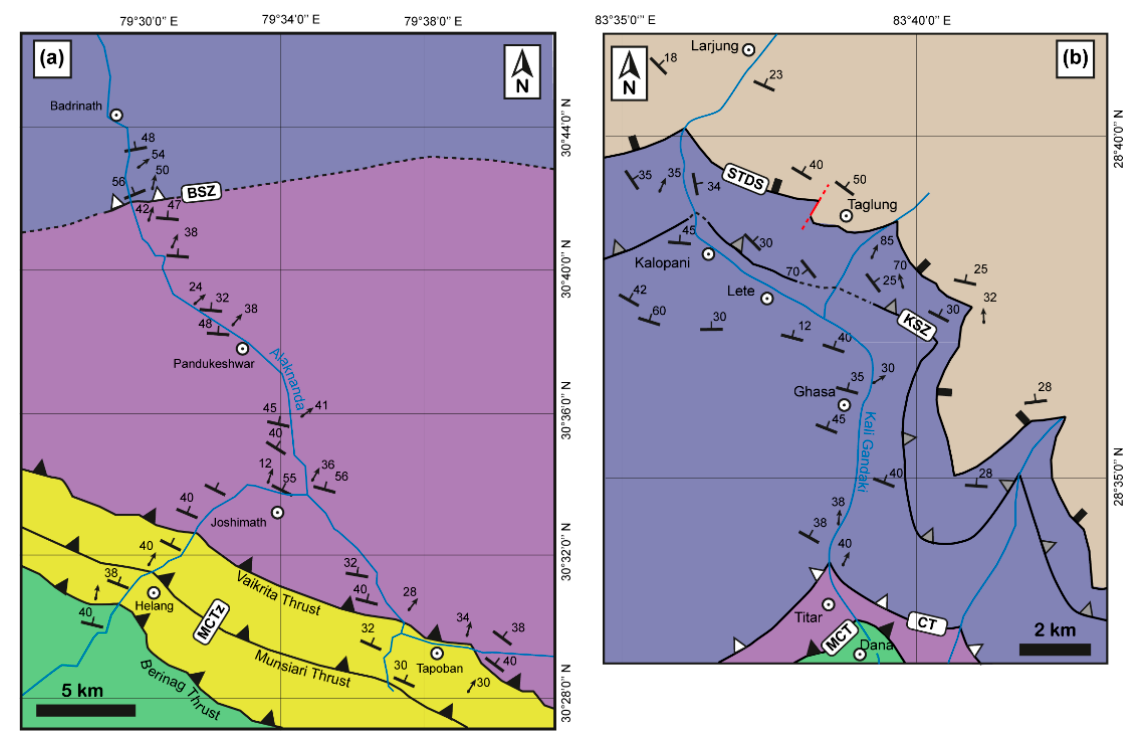
Figure 10. ( a ) Geological map of NW India [128]; ( b ) geological map of central Nepal. Same legend as in Figure 9 [125].